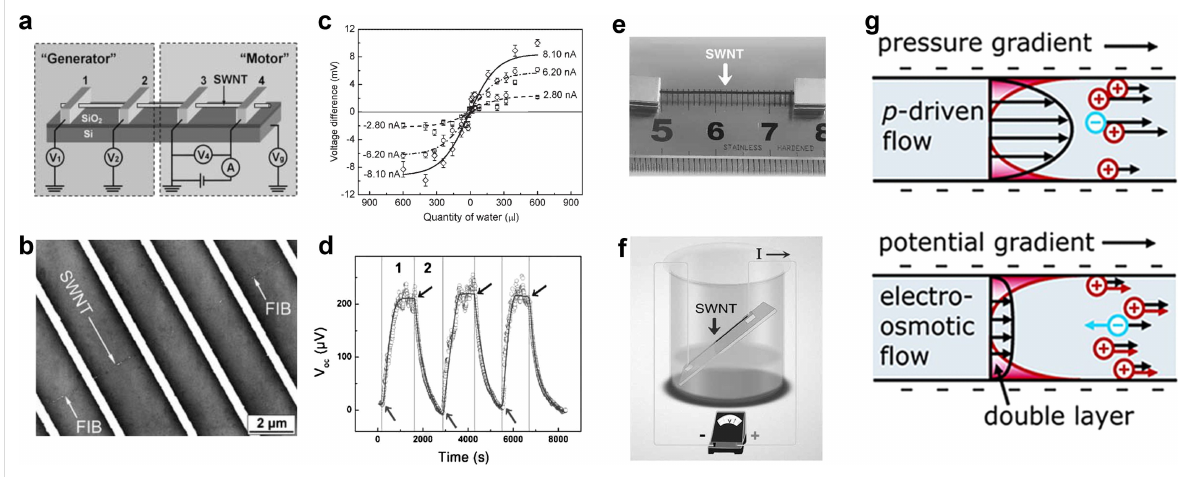
Figure 1: (a) The water flow is driven by an external electric field in the “motor” part, so the water molecules gain kinetic energy, and then an electro- motive force is generated in the "Generator" part. (b) A scanning electron microscopy (SEM) image of an individual single-walled carbon nanotube (SWNT) device. (c) Dependence of the induced voltage difference, Δ V , on the quantity of water injected into the chamber. Δ V increases with the quantity of water inside the chamber and tends to saturate at 500 μ L. It is nearly symmetric for either a positive or negative current. Figure 1a–c were reproduced from [7], Y. Zhao et al., “Individual Water-Filled Single-Walled Carbon Nanotubes as Hydroelectric Power Converters”, Adv. Mater., with permission from John Wiley and Sons. Copyright © 2008 WILEY-VCH Verlag GmbH & Co. KGaA, Weinheim. This content is not subject to CC BY 4.0. (d) Single-walled carbon nanotubes convert collected energy into voltage output with repeatability. (e) An image of a suspended SWNT rope. (f) Schematic diagram of an ethanol evaporation energy collection device. Figure 1d–f were reproduced from [44], Liu, Z. et al., “Surface-energy generator of single-walled carbon nanotubes and usage in a self-powered system”, Adv. Mater., with permission from John Wiley and Sons. Copy- right © 2010 WILEY-VCH Verlag GmbH & Co. KGaA, Weinheim. This content is not subject to CC BY 4.0. (g) Schematic illustration of electrokinetic effects. Top: A pressure-driven flow carries the net ionic charge within the double layer, generating a streaming current. Bottom: A potential gradient generates both an electro-osmotic fluid flow (black arrows) and an additional electrophoretic ion velocity (colored arrows). Figure 1g was